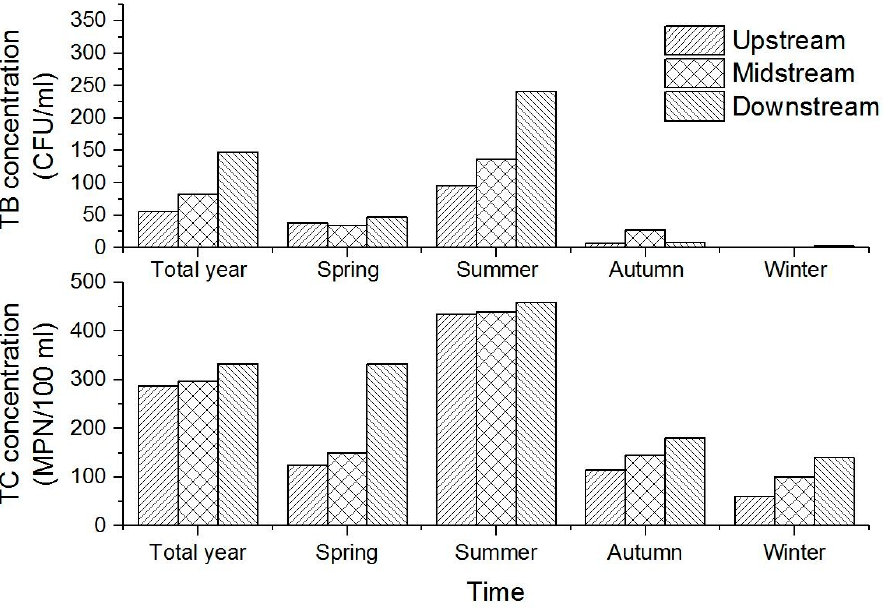
Figure 4. TB and TC concentrations between different seasons and locations.